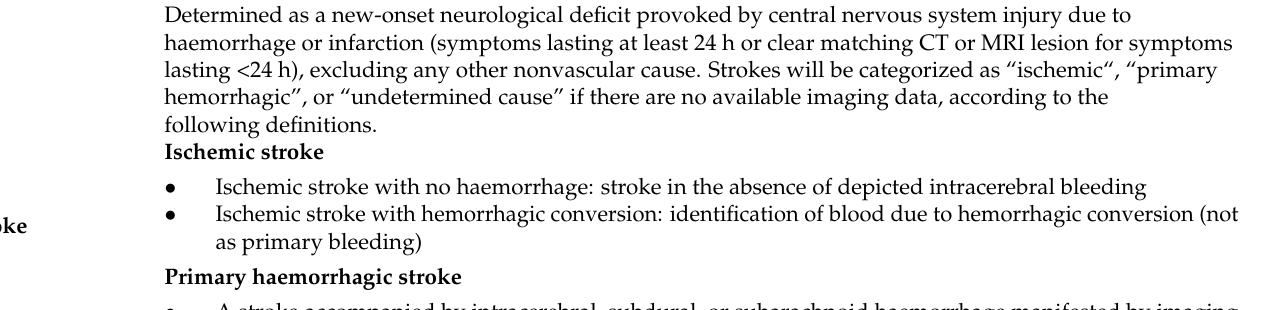
Table 1. Clinical events